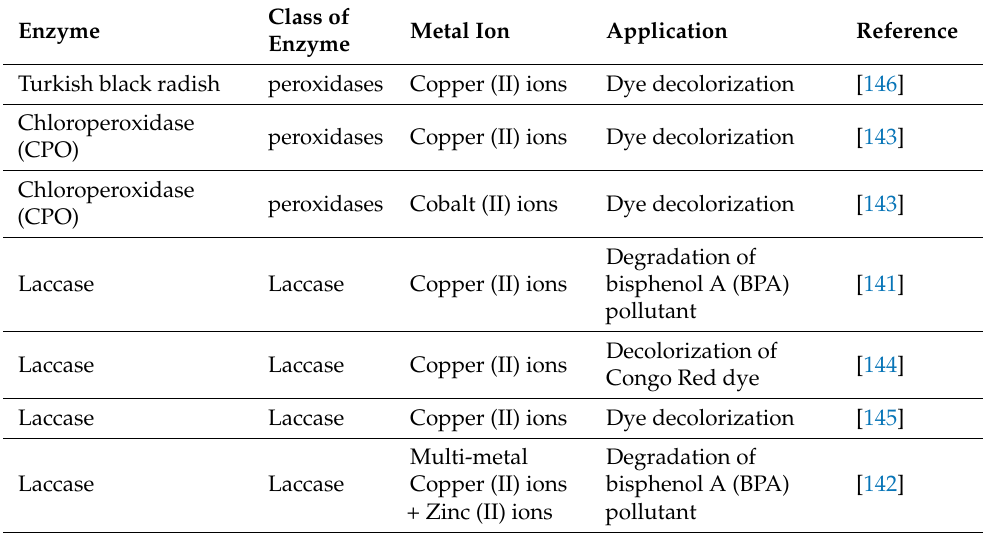
Table 4. Examples of different enzymes immobilized on hNFs for water remediation. Class Enzyme